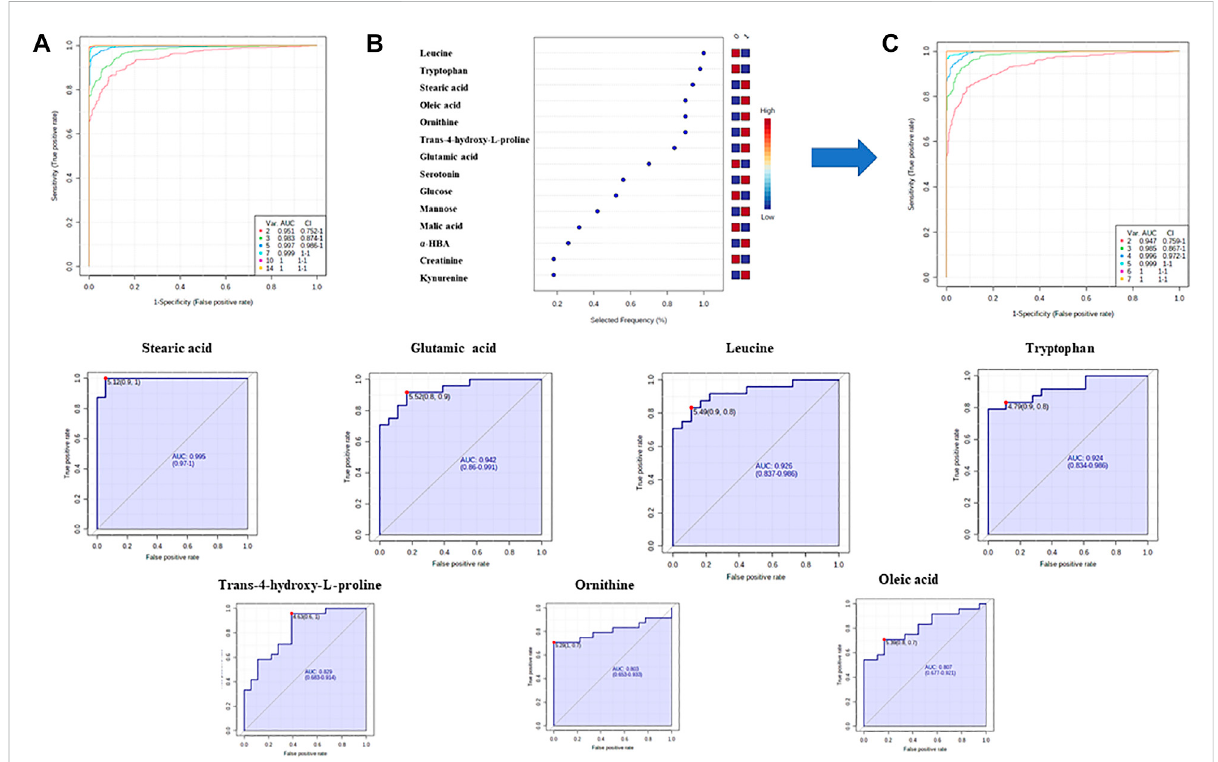
FIGURE 6 Discovery of a potential biomarker panel in T2DM by GC – MS untargeted metabolomics. (A) ROC curves and AUC values based on SVM classi fi cation model for all statistically signi fi cant metabolites; (B) — plot of the most important and frequently selected variables during the